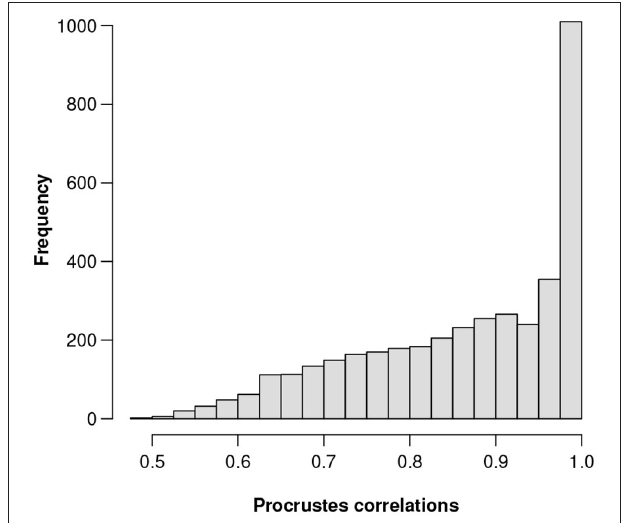
FIGURE 1 | Histogram of the 3,937 Procrustes correlations of the respective sets of candidate ALRs, each set computed using a different reference